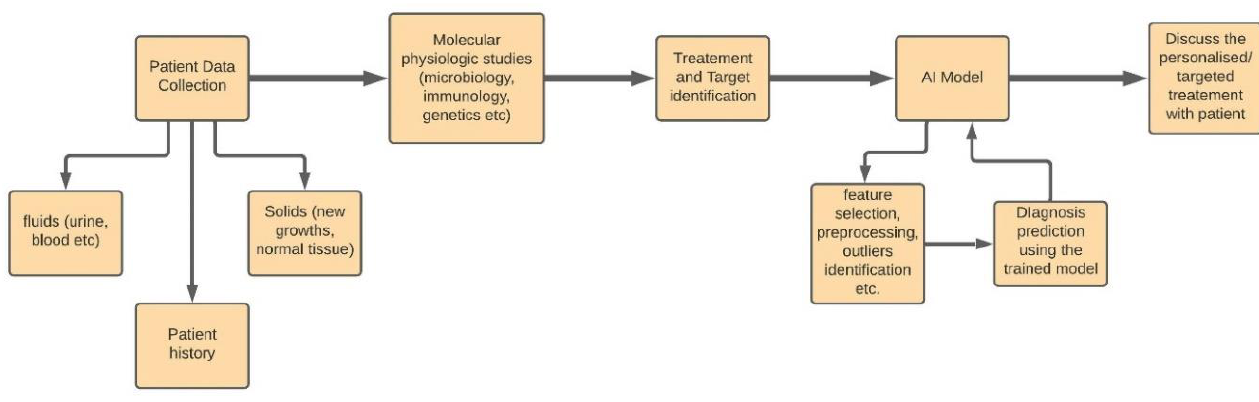
Figure 7. The Process Flow Representation of Personalized Medicine.